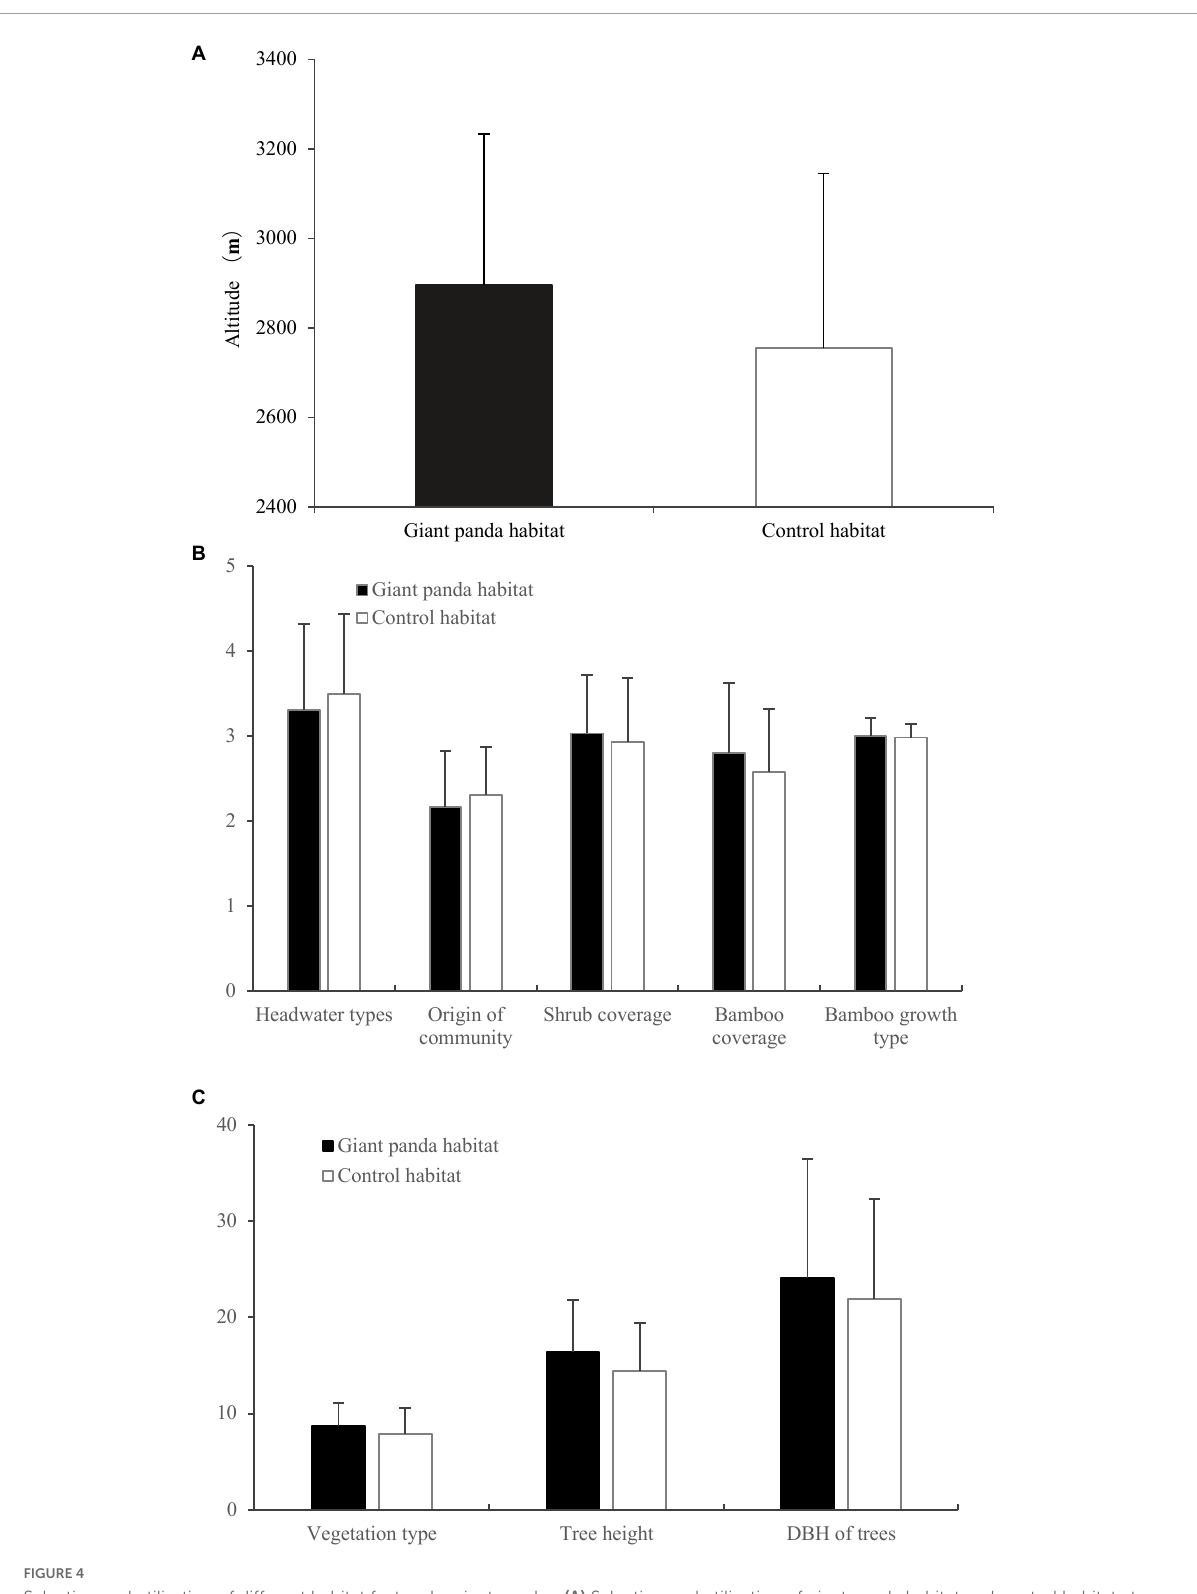
FIGURE4 Selection and utilisation of different habitat factors by giant pandas. (A) Selection and utilization of giant panda habitat and control habitat at altitude. (B) Selection and utilization of giant panda habitat and control habitat at headwater types, origin of community, shrub coverage, bamboo coverage and bamboo growth type. (C) Election and utilization of giant panda habitat and control habitat at vegetation type, tree height and DBH of trees.